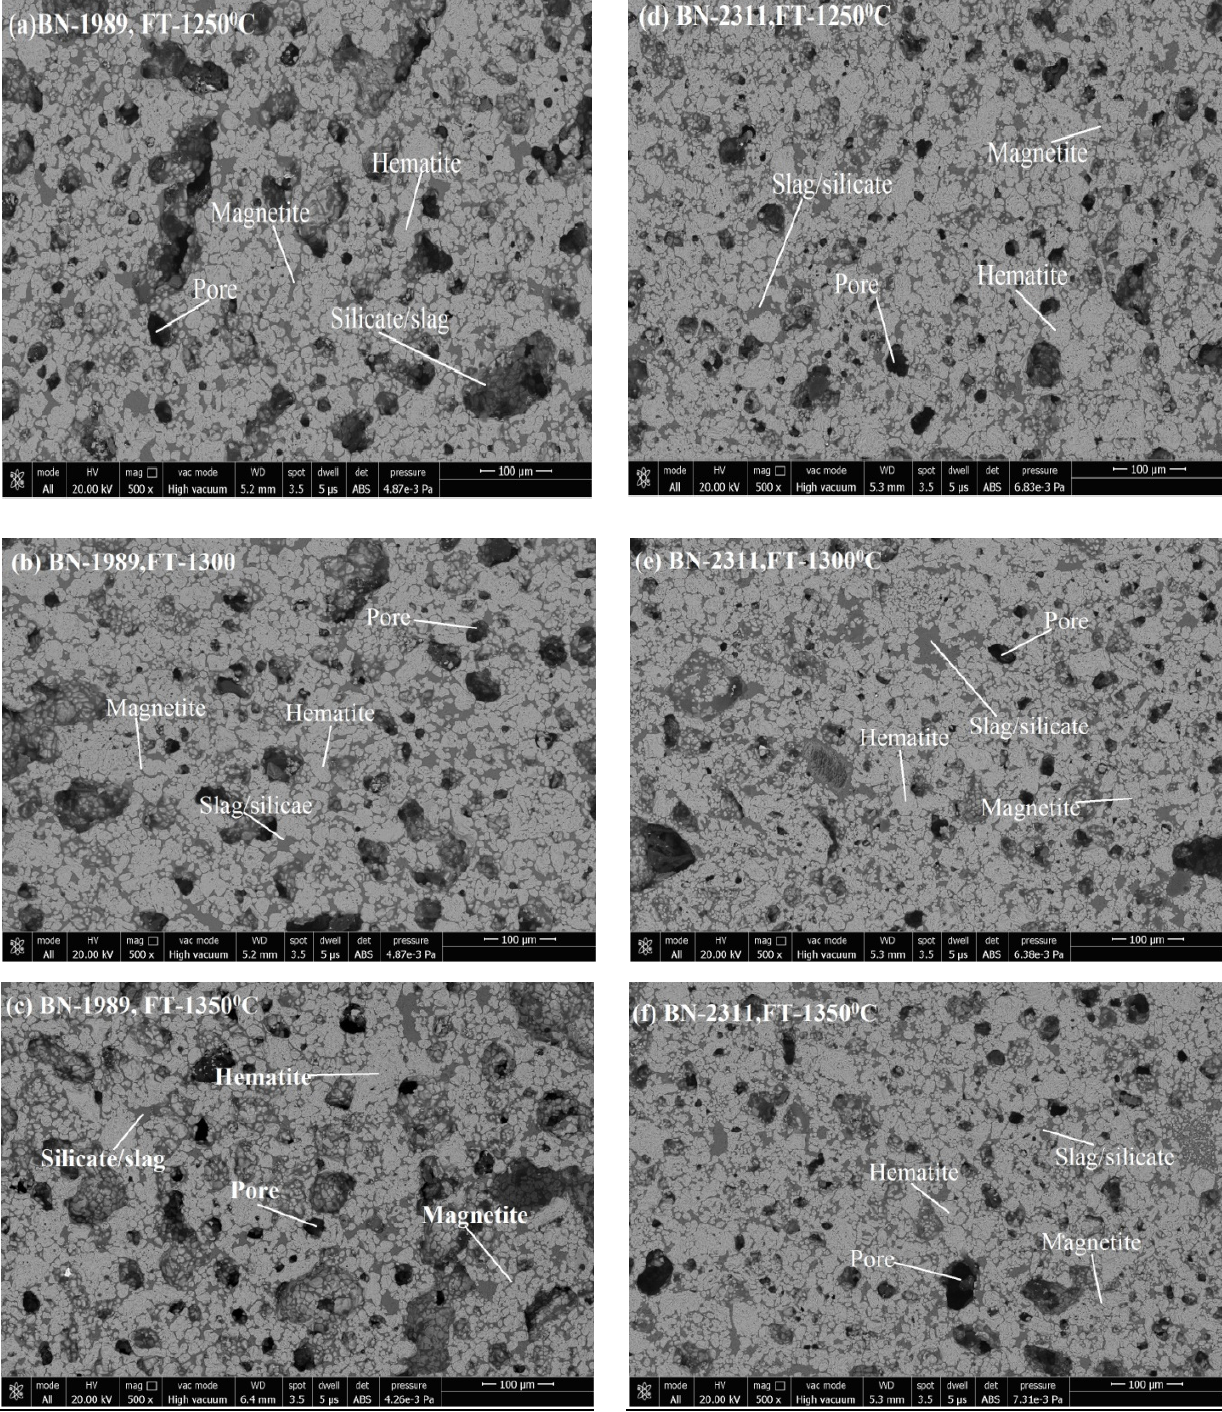
Figure 7. SEM Microstructure of ( a ) M1A, ( b ) M1B, ( c ) M1C, ( d ) M2A, ( e ) M2B, and ( f ) M2C pellets microstructure.